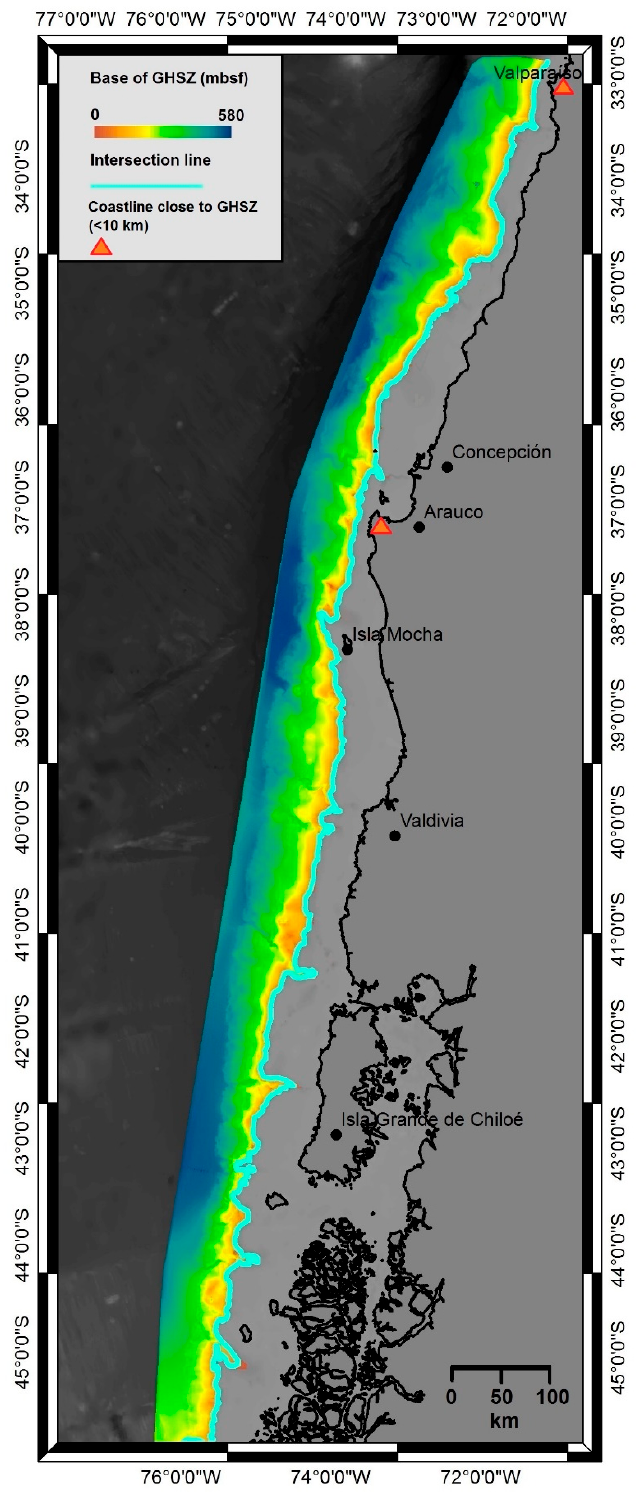
Figure 3. Depth of the base of the GHSZ below the seafloor for Scenario S0 (present-day conditions). The base of the GHSZ is deeper for cool colors (lower slope) and shallower for warm colors (upper slope-shelf). The light-blue line marks the intersection between the base of the GHSZ and the seafloor. The red triangles highlight coastal locations very close to the intersection.